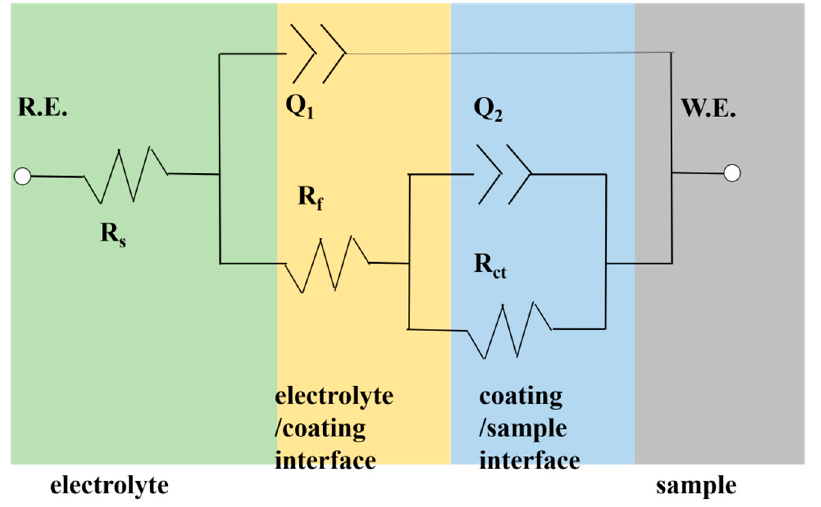
Figure 3. Equivalent circuits for untreated and simultaneously chemical-converted treated multi- metal samples.